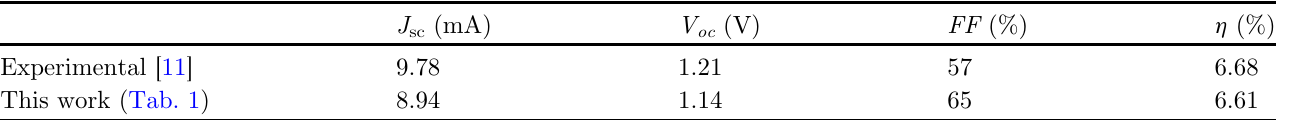
Table 2. Comparison between experimental data and simulation of the AZO/Zn experimental optimum germanium composition of x = 0.62.